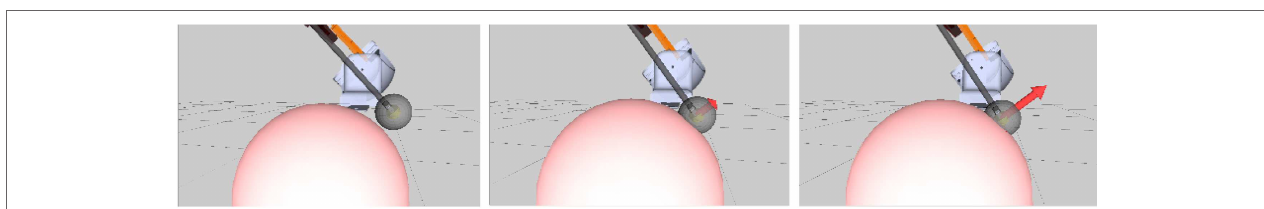
FIGURE 8 | The elasticity of the SPR while interacting with environment . The deeper the SPR is pressed, the greater is the normal force vector